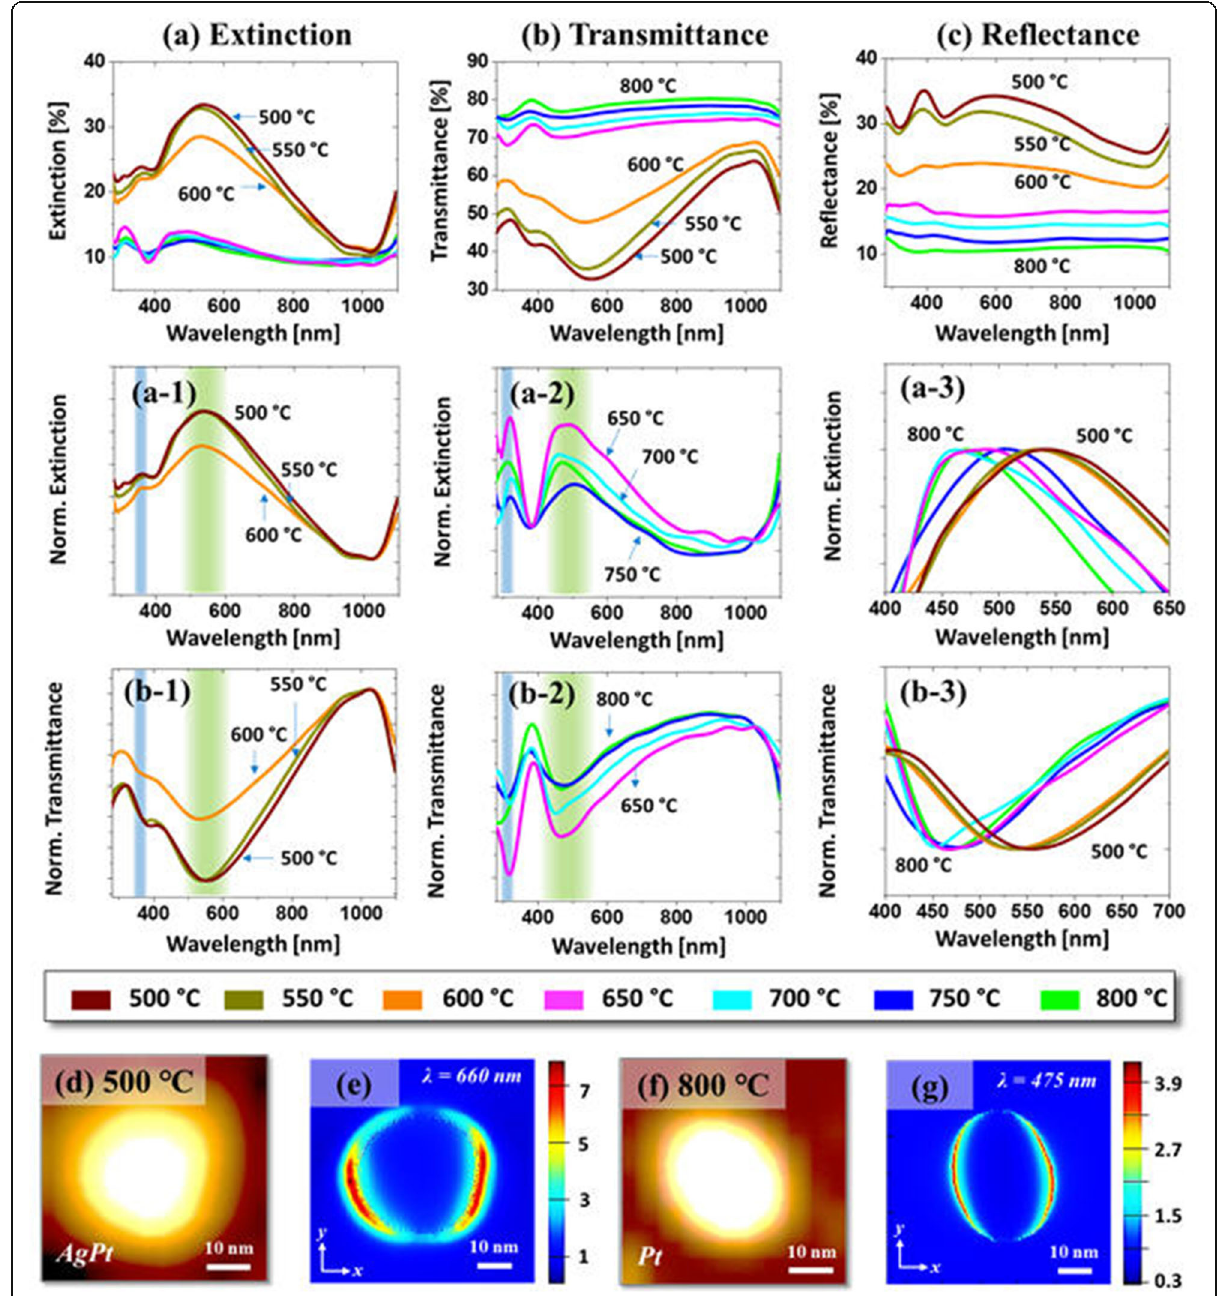
Fig. 2 Optical properties of the AgPt and Pt NPs fabricated with the Ag7nm/Pt1.5 nm bilayers. a – ( a-3 ) Extinction and normalized extinction spectra. b – ( b-3 ) Transmittance and normalized transmittance spectra. c Reflectance spectra. The reflectance and transmittance spectra were acquired from the measurement and the extinction spectra were calculated by the relation: E [%] = 100 [%] − ( R + T ) [%]. d, f AFM images of the typical AgPt and Pt NPs selected for finite-difference time domain (FDTD) simulations. e, g Corresponding e-field distribution at resonant